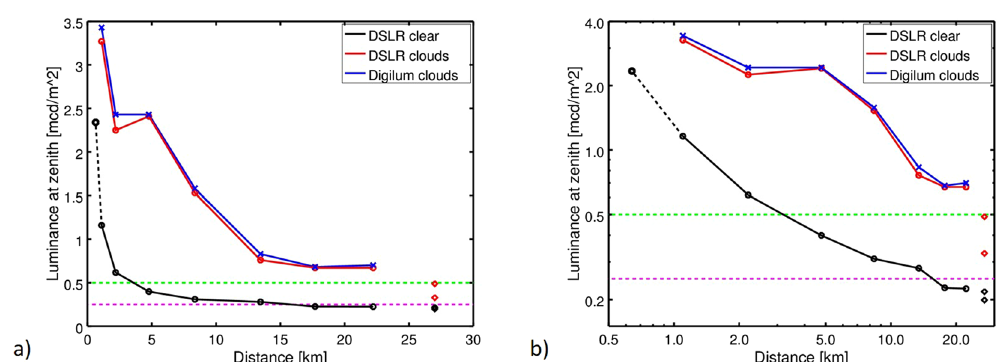
Figure 2. Luminance at the zenith as a function of the distance from the city center of Balaguer measured at two differentnights taken at the transects with clear sky (black open circle and solid line) and partly cloudy sky (red open circles and solidline) in a linear scale ( a ) and a double logarithmic scale ( b ). Additionally data from the Astronomical park at 27.2 km distance isshown as black (clear sky) and red (partly cloudy sky) diamonds in both plots, respectively. For the clear sky case, an extra datapoint closer to the town center (600 m) was taken, which is indicated by the black dashed line. For the partly cloudy night, comparative data obtained with the Digilum luminance meter is shown in blue. The dashed magenta line indicates the value ofa “typical” clear sky (0.250 mcd/m2) and the green dashed line a value twice as much (0.50